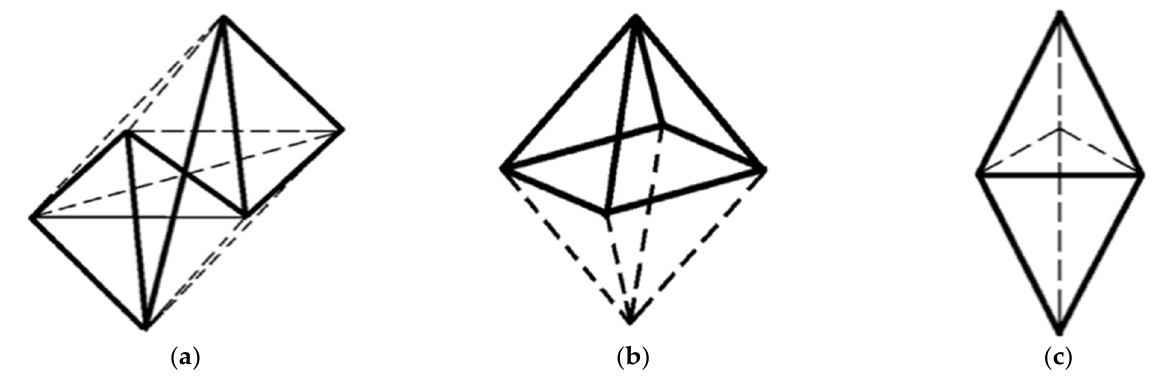
Figure 20. Rearrangement of two tetrahedra into an octahedron (CN 6) ( a ), a semi-octahedron (CN 5) ( b ), and a trigonal bipyramid ( c ).